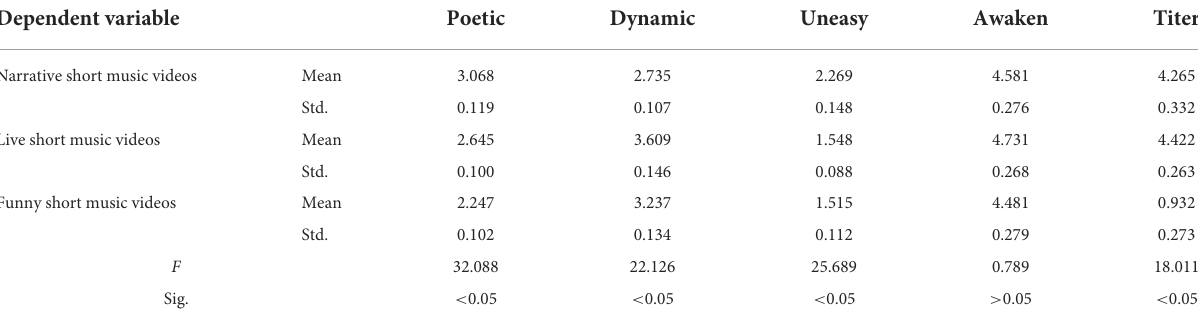
TABLE 5 Hypothesis testing of narrative short music videos.